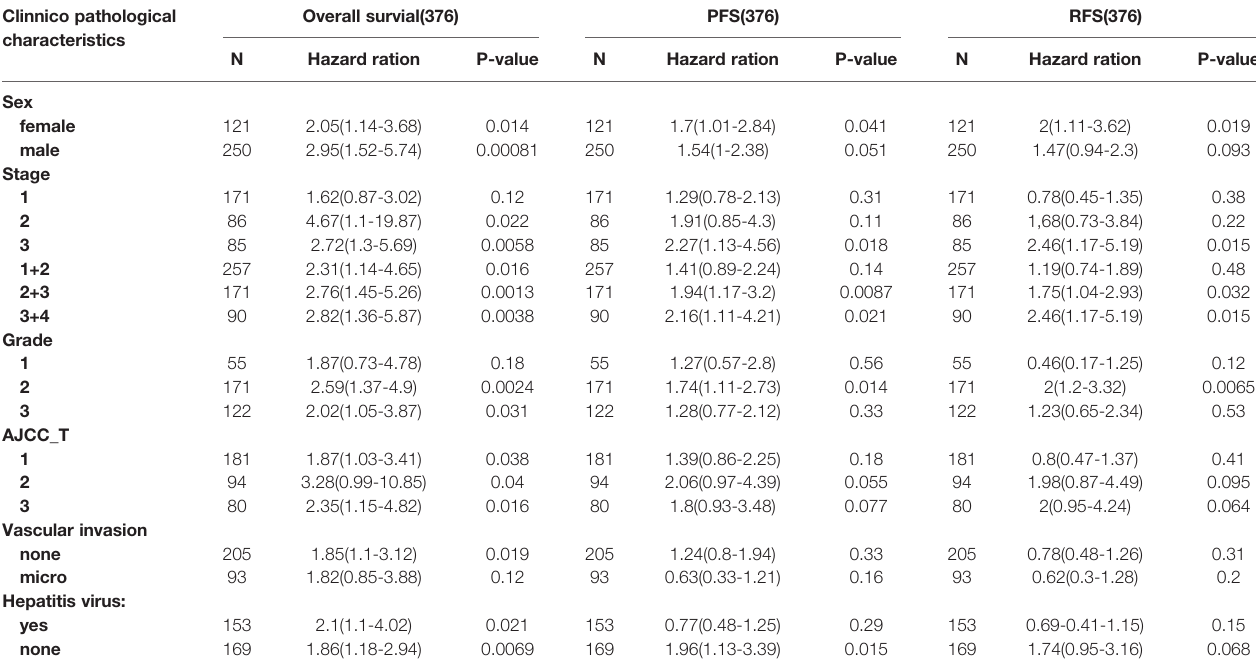
TABLE 1 | Correlation of ASRGL1 expression and clinical prognosis in hepatocellular carcinoma with different clinicopathological factors by Kaplan-Meier plotter. Clinnico pathological